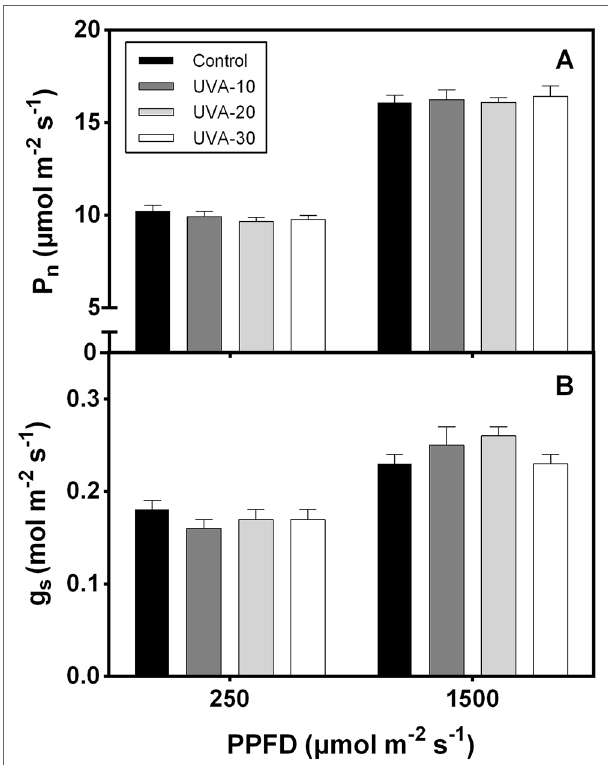
FIgURe 3 | (A) Net leaf photosynthetic rate (P n ) and (B) stomatal conductance